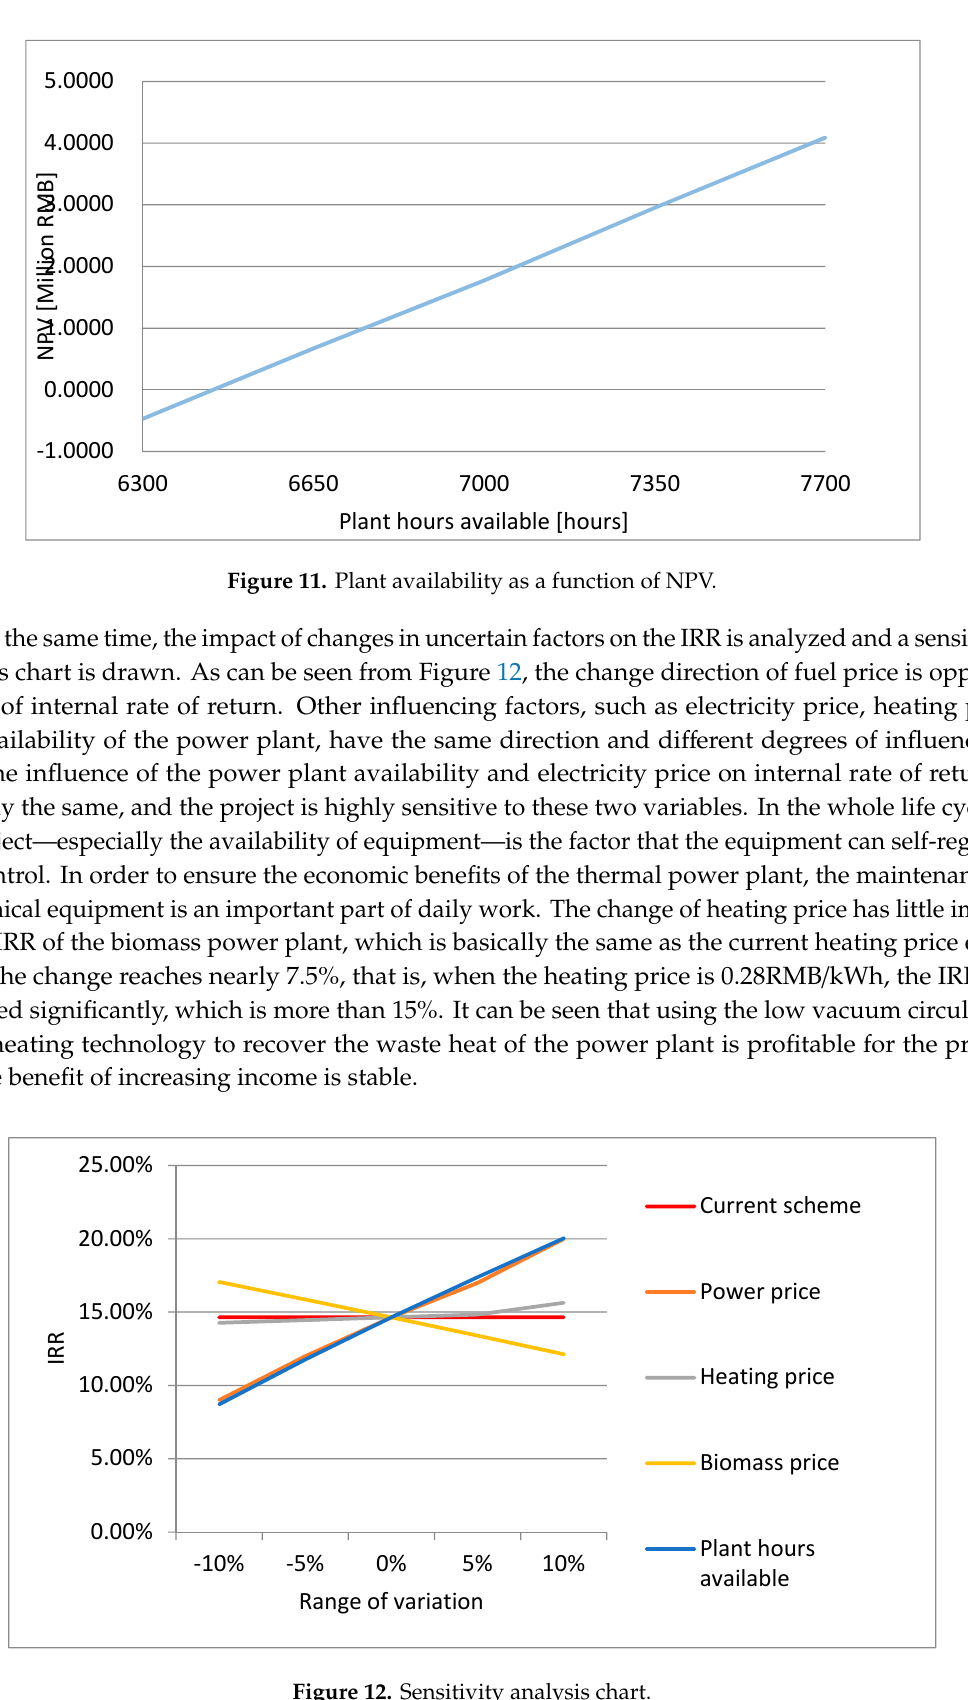
Figure 12. Sensitivity analysis chart.